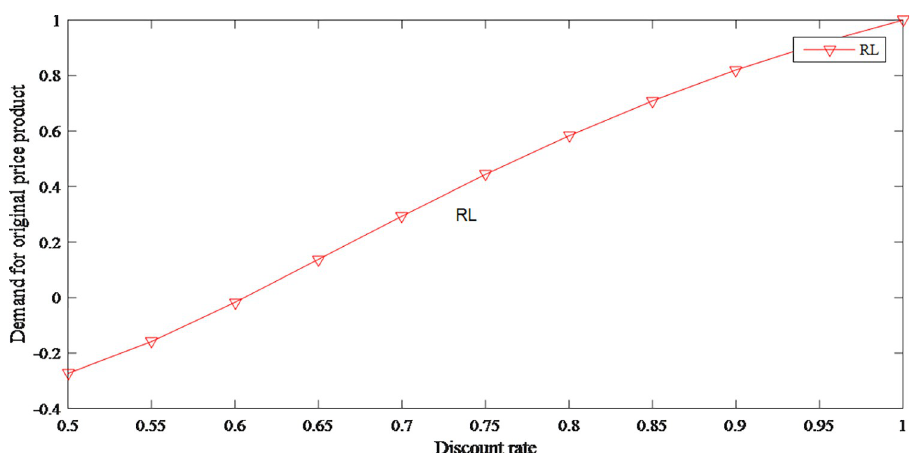
Fig 21. The impact of discount rate on demand for original price product.